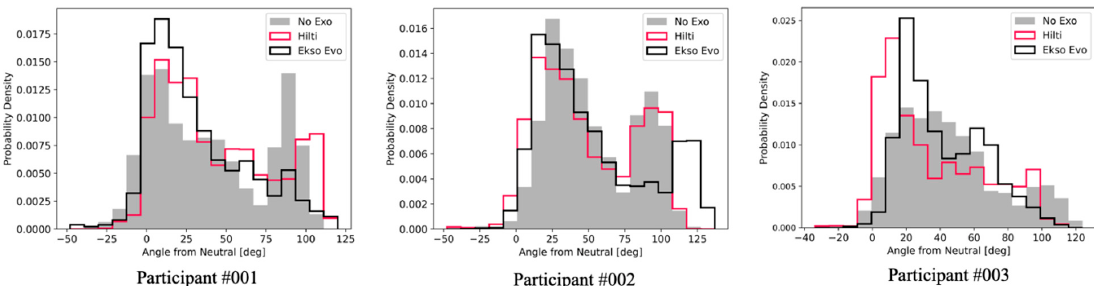
Figure 10. Histograms of flexion/extension of the left shoulder for block installation.